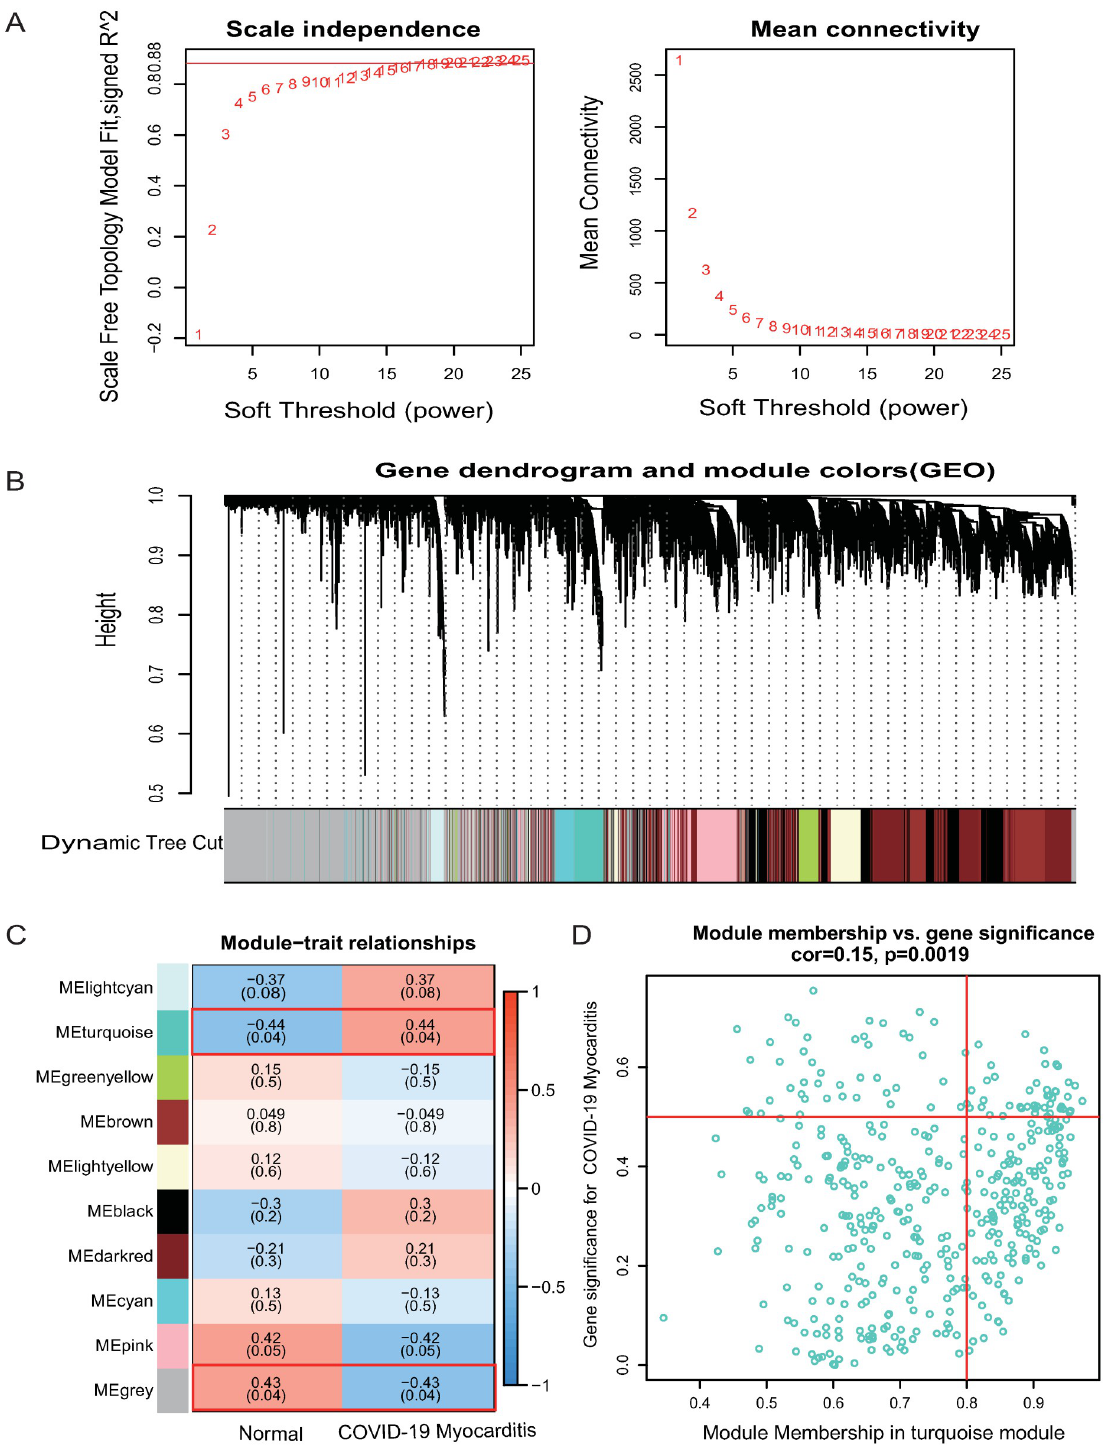
Fig 3. Identification of significant modules and genes of GSE167028 by WGCNA. (A) Network topology analysis with different soft thresholds. The scale-free R^2 was 0.88 and the soft threshold was 20. (B) A cluster dendrogram of module-specific colors showed 10 co- expressed gene modules, each containing more than 80 genes. (C) Correlation between disease groupings and gene modules. (D) The scatter plot of Gene significance vs Module membership in the turquoise co-expression module.